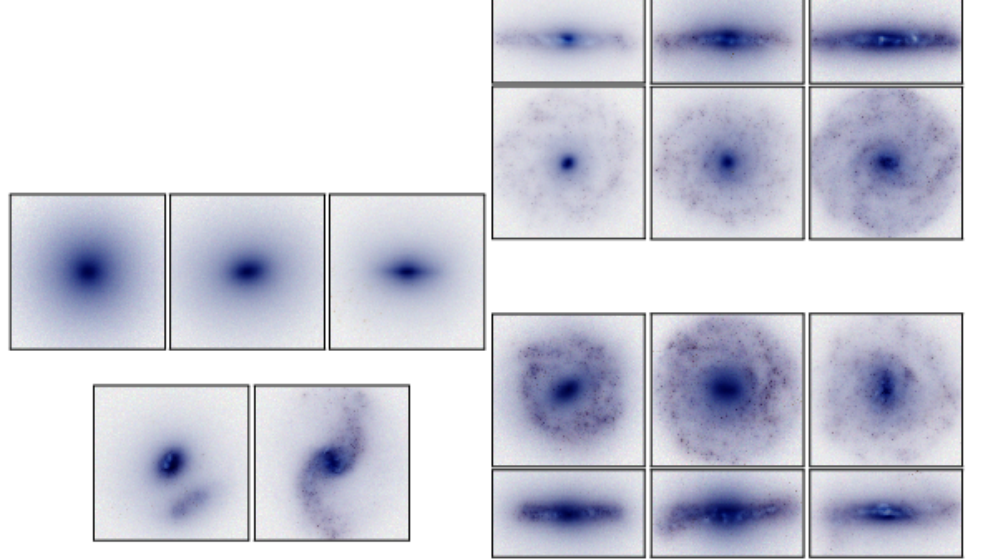
Figure 5. Figure from Schaye et al. [82]. The figure shows example galaxies extracted from the Evolution and Assembly of GaLaxies and their Environments (EAGLE) simulated volume at z = 0. Images have been created using the radiative transfer code SKIRT [85] using light in the u, g, and r bands and accounting for dust extinction. Each image is 60 kpc on a